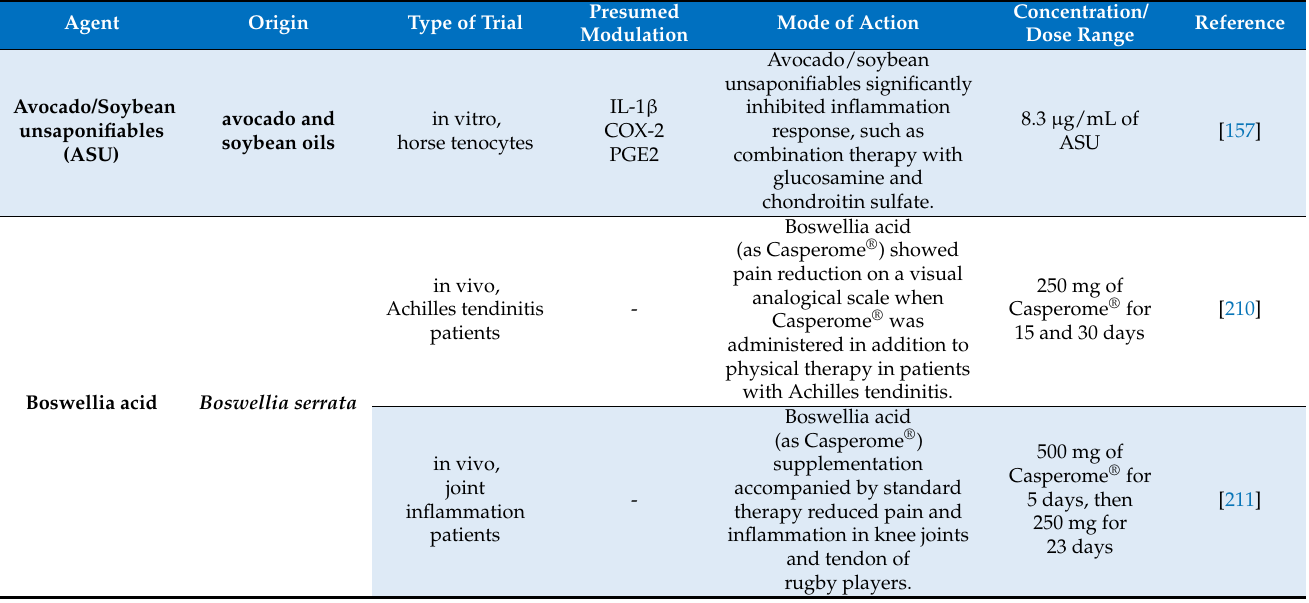
Table 1. Tendon-supporting effects of